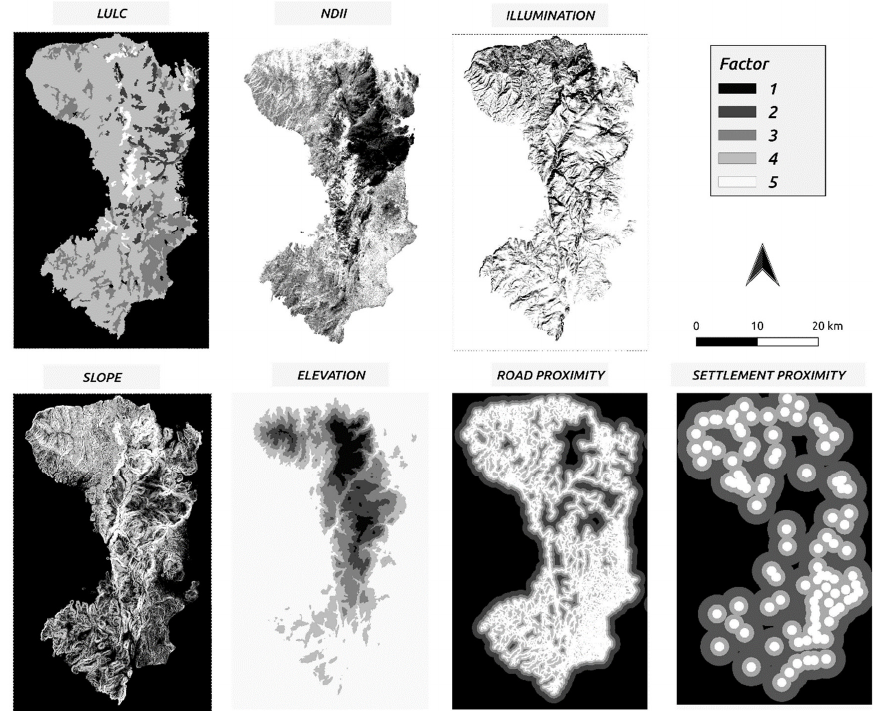
Figure 6. The results for all the individual factors examined in the fire risk model proposed. ISPRS Int. J. Geo-Inf. 2020 , 9 , x FOR PEER REVIEW